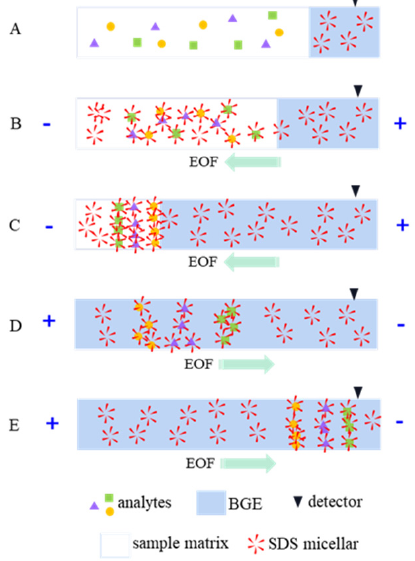
Figure 6. Schematic presentation of this LVSS-MEKC method. A. A large volume of a sample is injected hydrodynamically. B. SDS micelles transported together with the analytes migrate rapidly toward the outlet end. C. The analytes were enriched and arranged in order of pKa values. D. The sample matrix was pumped out from the inlet and the analytes started to separate. E. The analytes migrated to the detector according to the value of pKa.